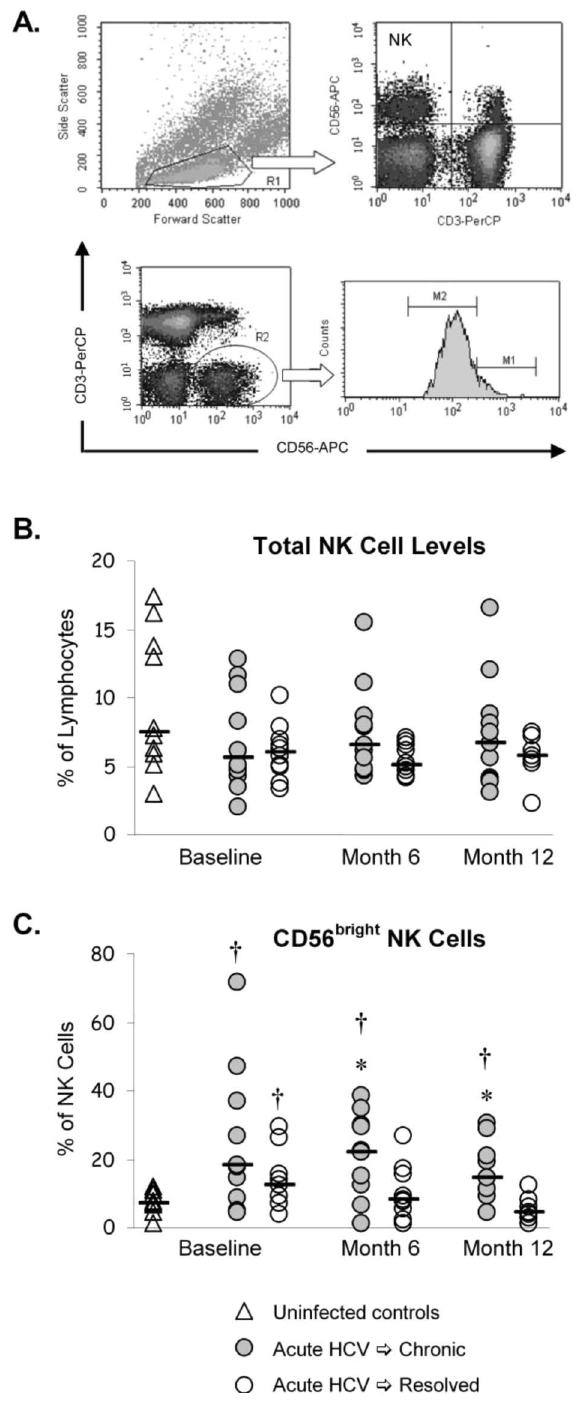
Figure 1. Frequency of NK cells and the immature/regulatory CD56 bright subset in acute HCV infection. A) Multi-parameter flow cytometric analysis was used to determine if the levels of peripheral NK cells (CD56 + CD3 - ) were altered in acute HCV infection. B) Levels of total NK cells at time of enrollment and at six and twelve month follow up time points are similar to those detected in normal uninfected controls irrespective of subsequent clinical outcome. C) In contrast, an increase in the proportion of NK cells displaying a CD56 bright immature/ regulatory phenotype was observed at baseline in acute HCV infection per se with a trend that was more pronounced in chronically evolving infection compared to patients who subsequently resolved